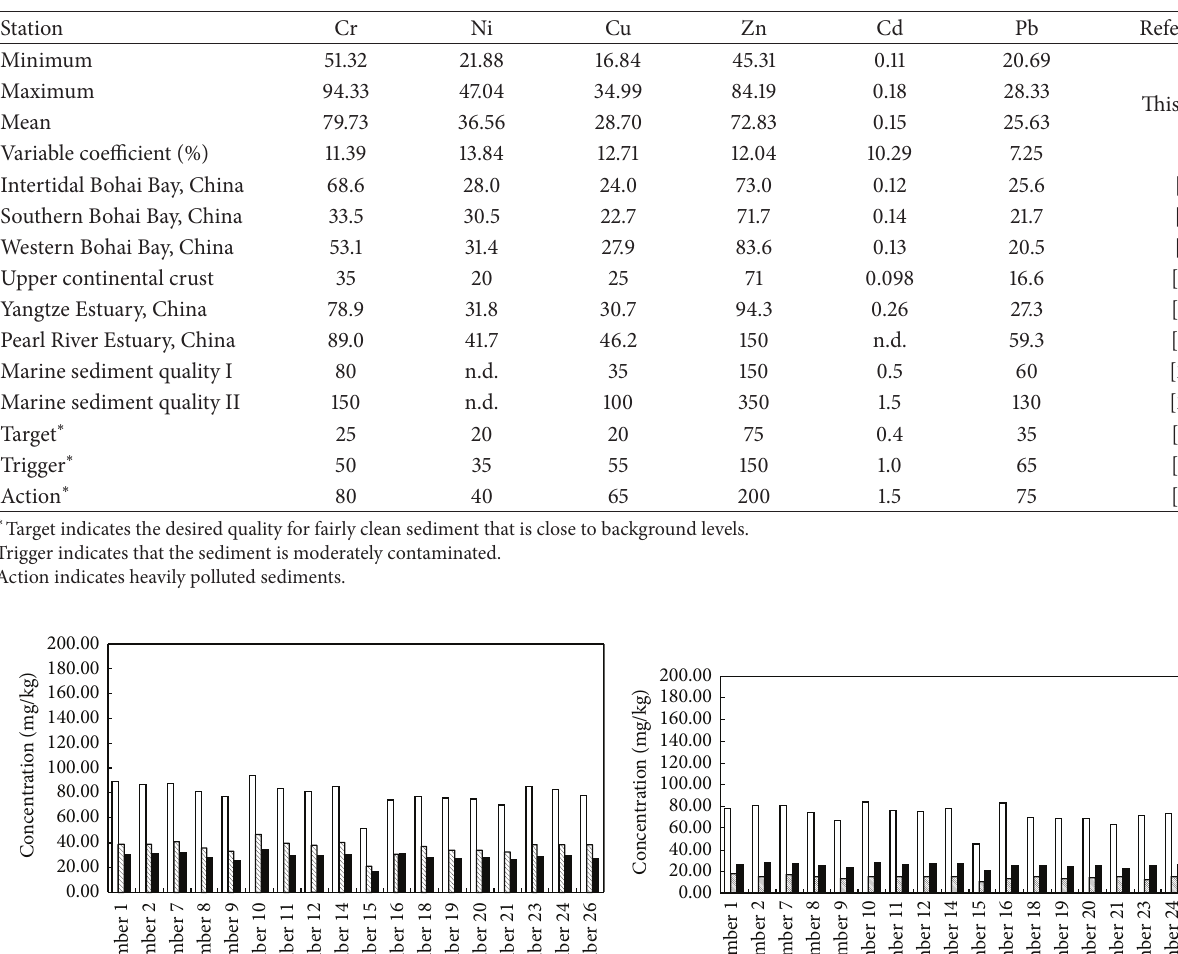
Table 1: Heavy metal concentrations in surface sediments of Bohai Bay and other Bays in China (mg/kg). Station Cr Ni Cu Zn Cd Pb